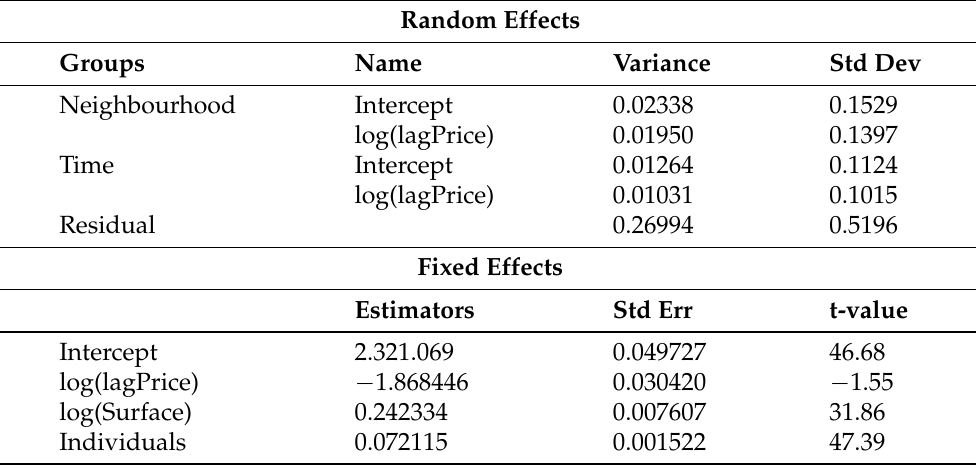
Table 1. Mixed model results. Two-way fixed and random